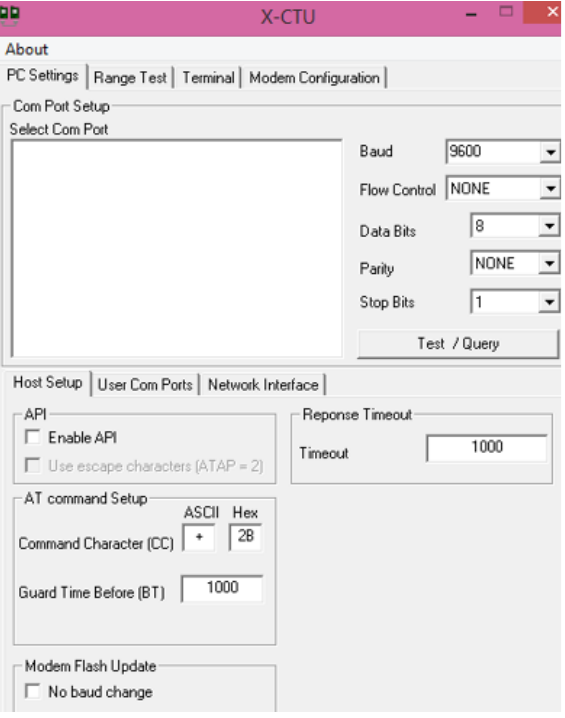
Figure 7. Testing ZigBee modules using XCTU